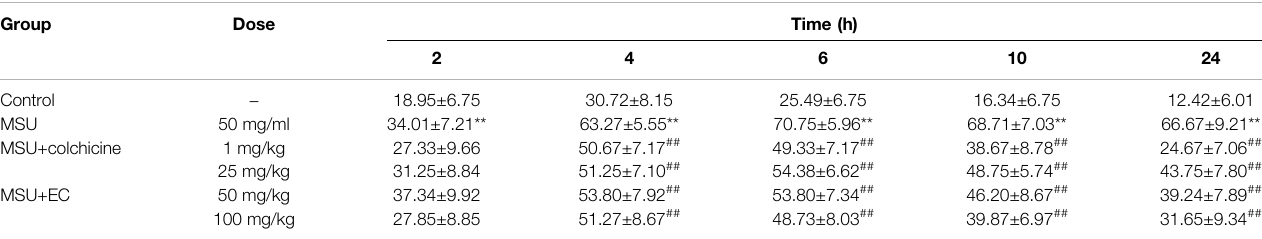
** p < 0.01 compared with the control group. ## p < 0.01 compared with the MSU group. Data are represented as mean ± SEM of ten mice per